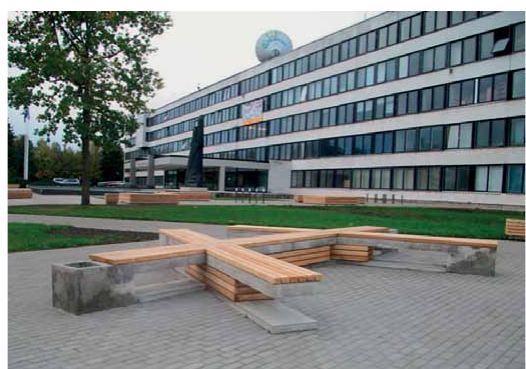
fig. 6. recreational spaces of KTu campus created by students for